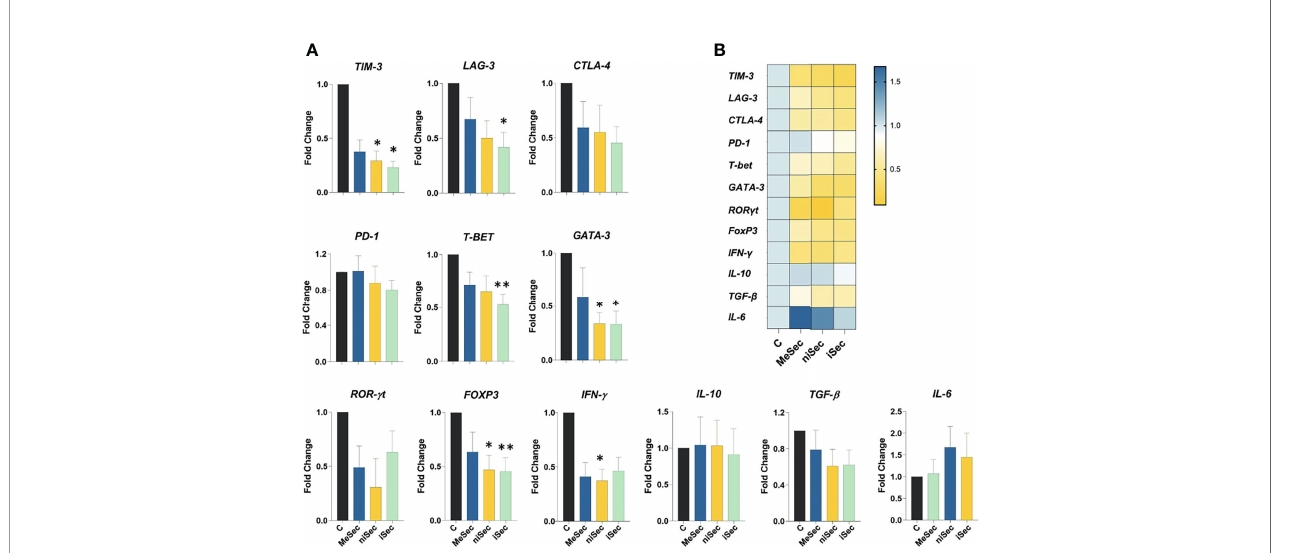
FIGURE 4 | Gene expression analysis in PBMCS. (A) TIM-3, LAG-3, CTLA-4, PD-1, T-BET, GATA-3, ROR- g t, FOXP3, IFN- g , IL-10 , TGF- b and IL-6 expression in PHA-activated-PBMCS cultured in RPMI (C, control) MeSec, niSec, and iSec. (B) Heat map of these speci fi c genes expressed in PHA-activated-PBMCS cultured in RPMI (C, control), MeSec, niSec, and iSec. Experiments were carried out with 4 PBMCs donors. Results are presented as mean ± SEM. *p < 0.05, **p <